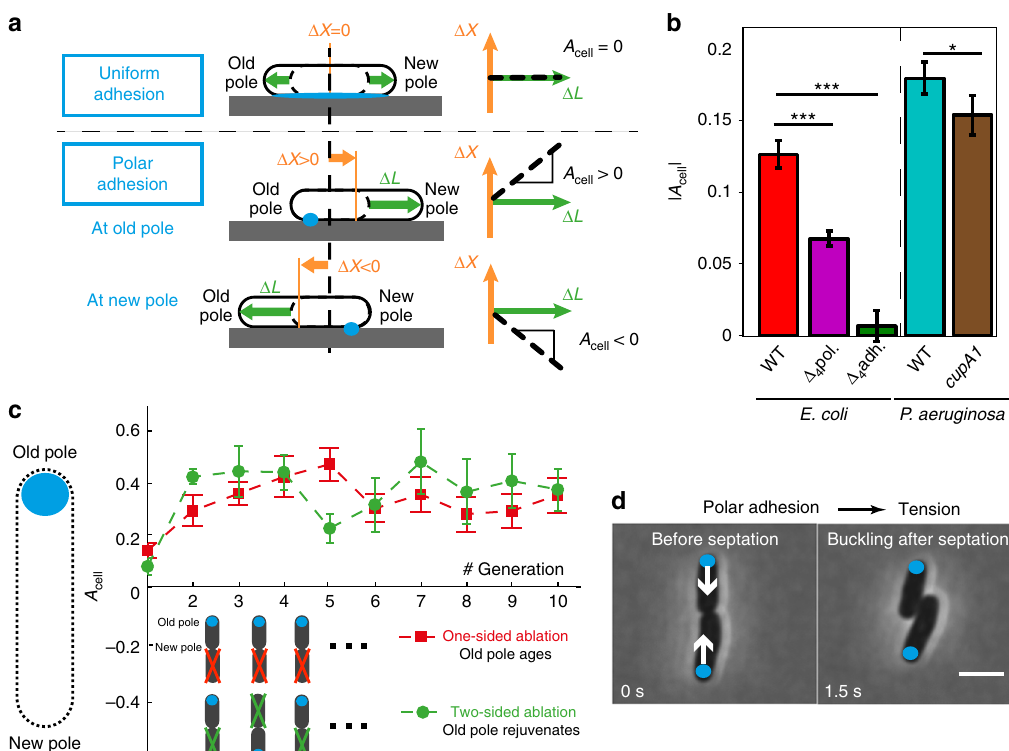
Fig. 2 Asymmetric adhesion puts daughter cells under tension. a Polar adhesion translates into a displacement of the center of mass (CM) of a growing cell. The level of adhesion asymmetry of a cell, A cell , is de fi ned according to Δ X = A cell Δ L , where Δ X is the displacement of the CM projected along the long axis of the cell and Δ L is cell elongation. The cell axis is oriented from the old pole toward the new pole. Asymmetry A cell j j may vary from 0 (uniform adhesion) to 0.5 (polar adhesion). b Average asymmetry A cell h ij j in populations of isolated bacteria for different strains: WT E. coli (red, N = 146) and different mutants ( Δ 4 adh green, N = 95; Δ 4 pol purple, N = 159) adhesion factors; WT P. aeruginosa PA14 (cyan, N = 111) and fi mbriae mutant cupA1 (brown, N = 98). Error bars are de fi ned as s.e.m. Statistical analysis was performed using the unpaired t -test of the fi tted distribution (*** p -value < 0.001; * p -value < 0.05; p -value(PA14 vs. cupA1 ) = 0.047). c Successive laser ablations of one daughter after the division of WT E. coli enable assessing the sign of A cell . Positive A cell indicates that bacteria adhere to the substrate at their old pole. d Images of WT E. coli before and after the reorganization that follows septation. Old poles are marked by a blue dot. Scale bar represents 3 μ